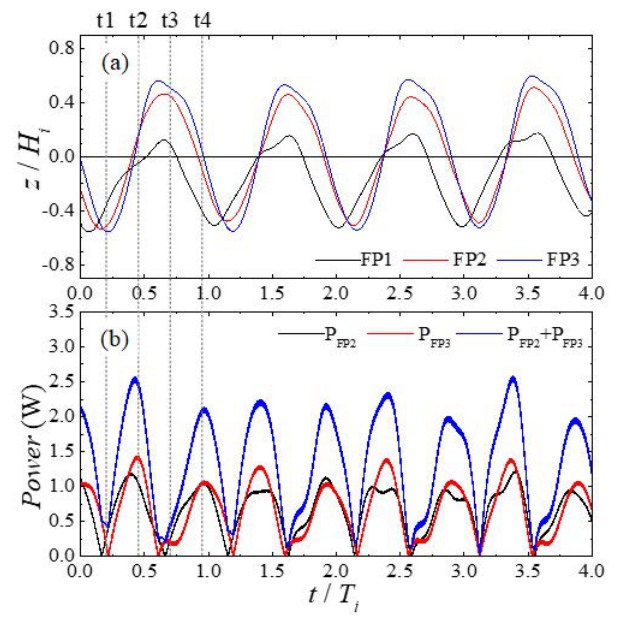
Figure 10. Dynamics and instantaneous output powers of the floaters. ( T i = 1.8 s, h = 0.6 m, H i / L i = 0.03): ( a ) motion; ( b ) output